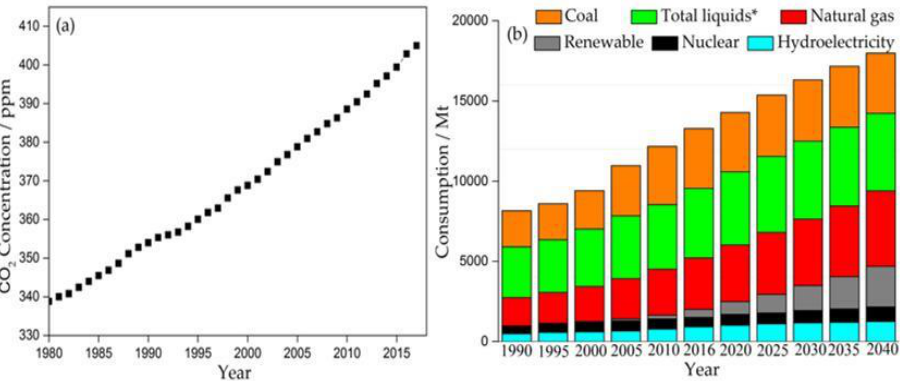
Figure 1. ( a ) Trends in atmospheric CO 2 concentrations (ppm). ( b ) Projected global energy consumption (Mt) from 1990 to 2040. Data from International Energy Agency.